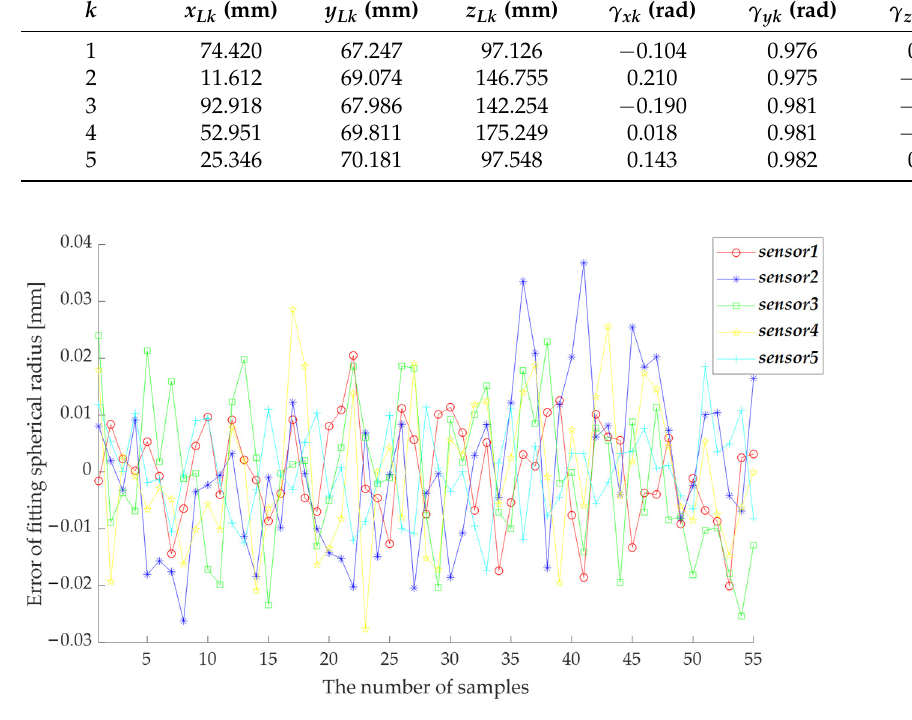
Figure 5. The spherical fitting error of each group of data.